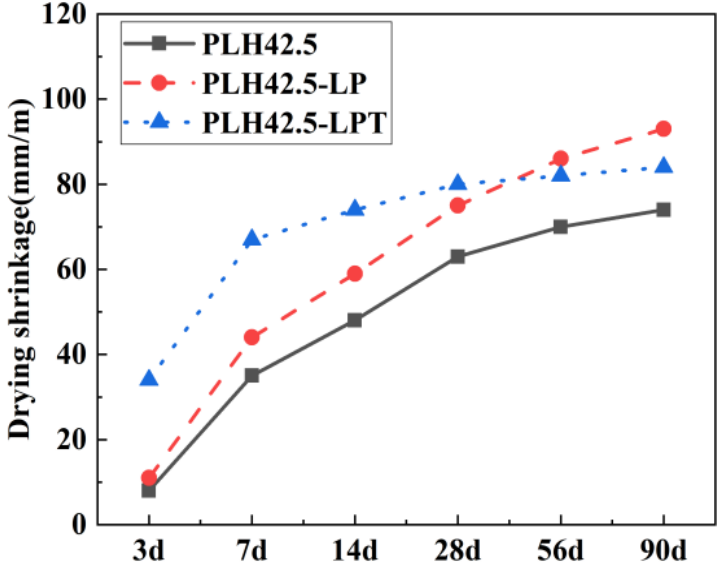
Figure 3. The drying shrinkage of mortars at different curing conditions.